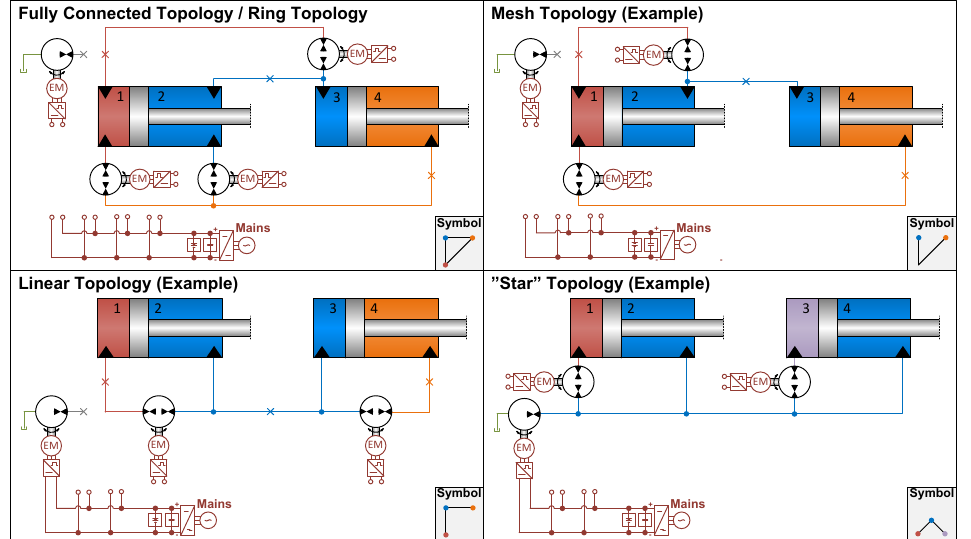
Figure 4. Examples of electro-hydraulic variable-speed drive network topologies in case of shared